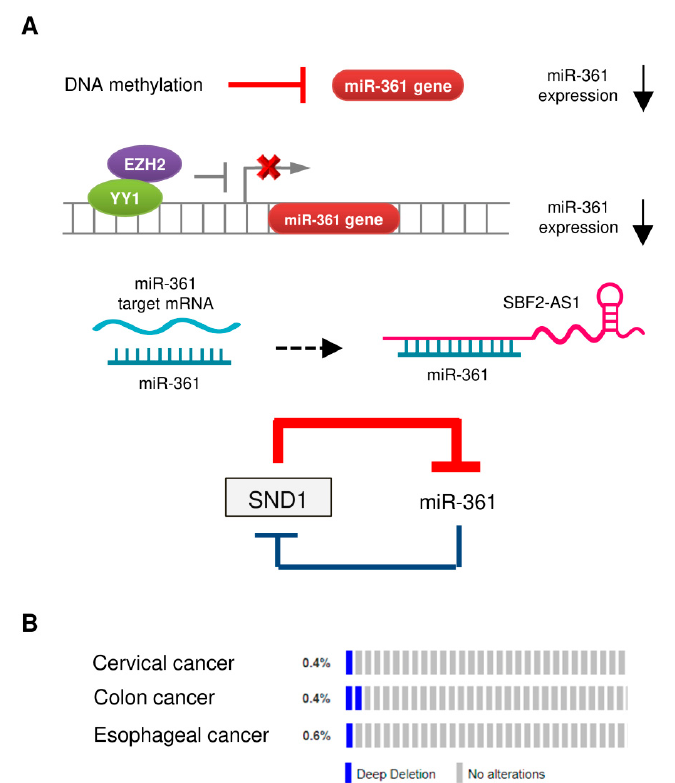
Figure 2. Mechanisms of miR-361 dysregulation in tumors. ( A ) Reported mechanisms responsible for miR-361 downregulation in tumors. ( B ) OncoPrint of cBioPortal showing the genetic alterations of miR-361 (deep deletion) in tumor samples obtained from The Cancer Genome Atlas (TCGA)-cervical cancer, TCGA-colon cancer, and TCGA-esophageal cancer datasets. Each bar indicates the individual cases and % on the left indicates the percentage of cases altered in the human miR-361 gene.